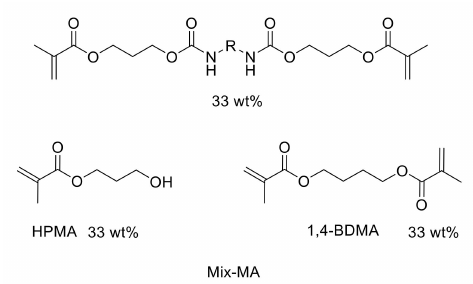
Figure 5. Benchmark methacrylate monomer blend